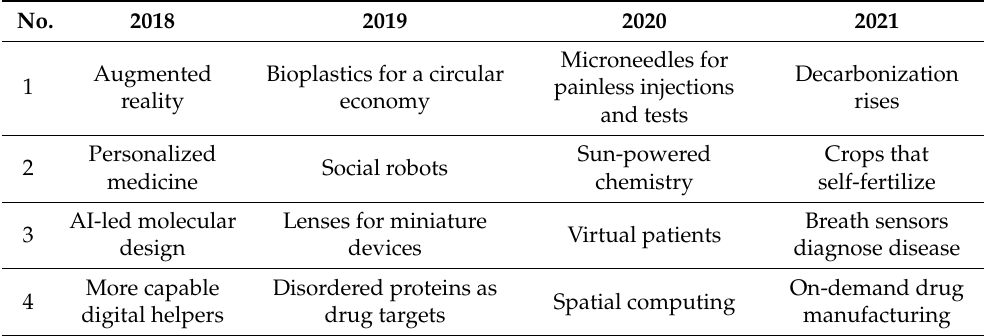
Table 1. World Economic Forum “Top 10 Emerging Technologies”